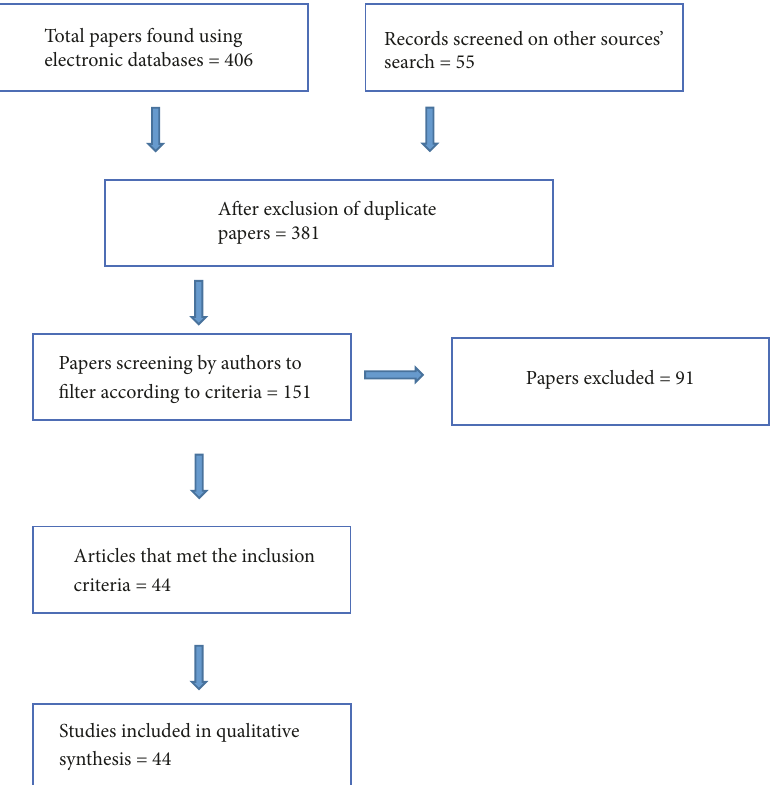
Figure 1: Flow of information through the different phases of the systematic